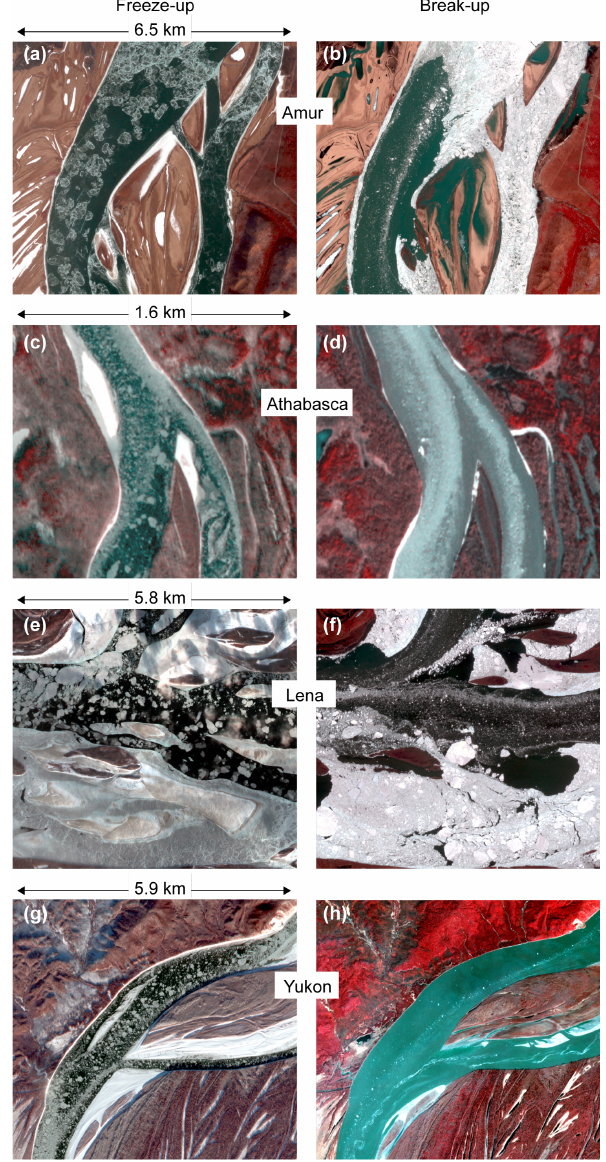
Figure 4. Typical river-ice conditions in Planet imagery (shown in infrared false colour) that are suitable for tracking ice floes to esti- mate water velocities. (a, c, e, g) During freeze-up; (b, d, f, h) dur- ing